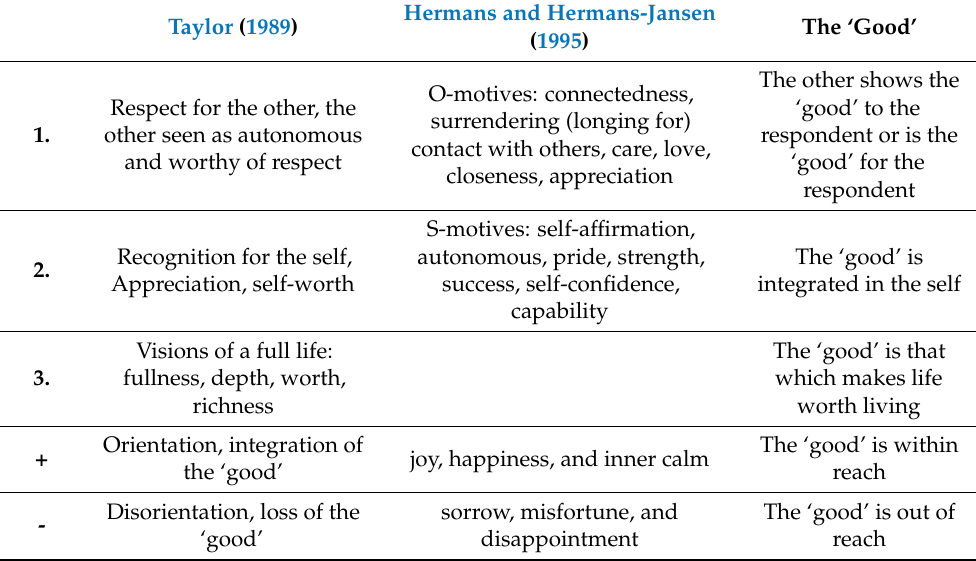
Table 9. Theoretical framework for analysis.